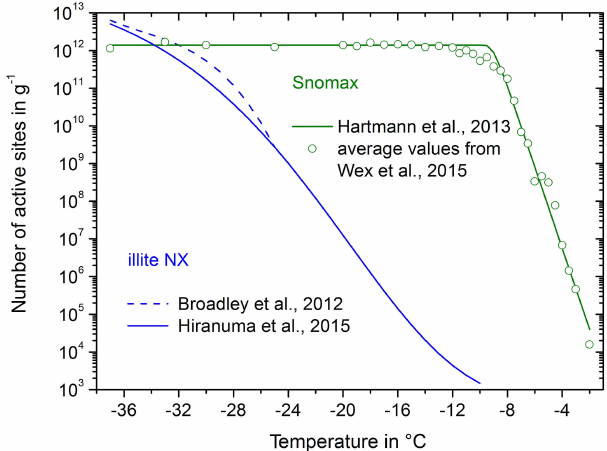
Figure 2. Numbers of active sites per unit mass as a function of temperature. Parameterizations for illite NX and Snomax ® based on the outcome of laboratory immersion freezing